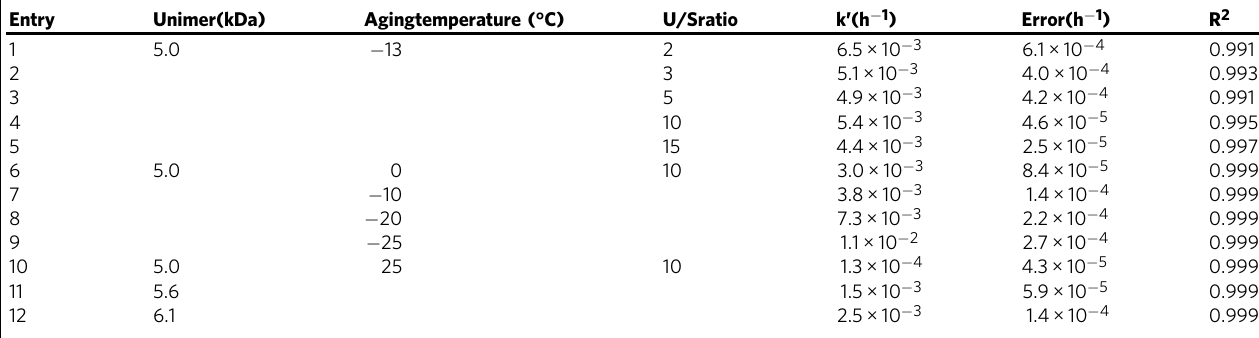
Table 1 Kinetic data for 2D CDSA experiments with different conditions: rate constants (k ’ ) with standard errors and R 2